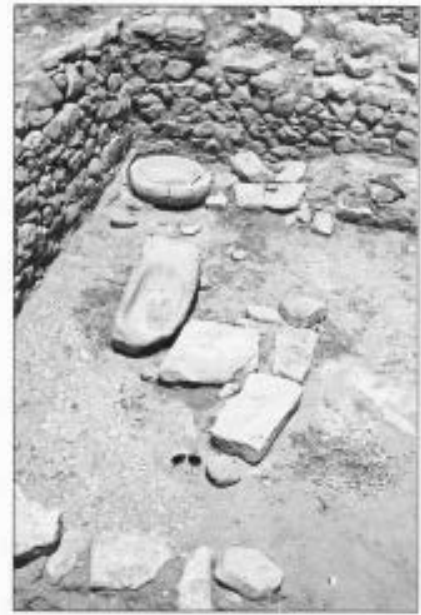
Figure 6 Groundstone grinding slab (centre left) and stone bowl (top left) in a house at the PPNB site of Beidha,